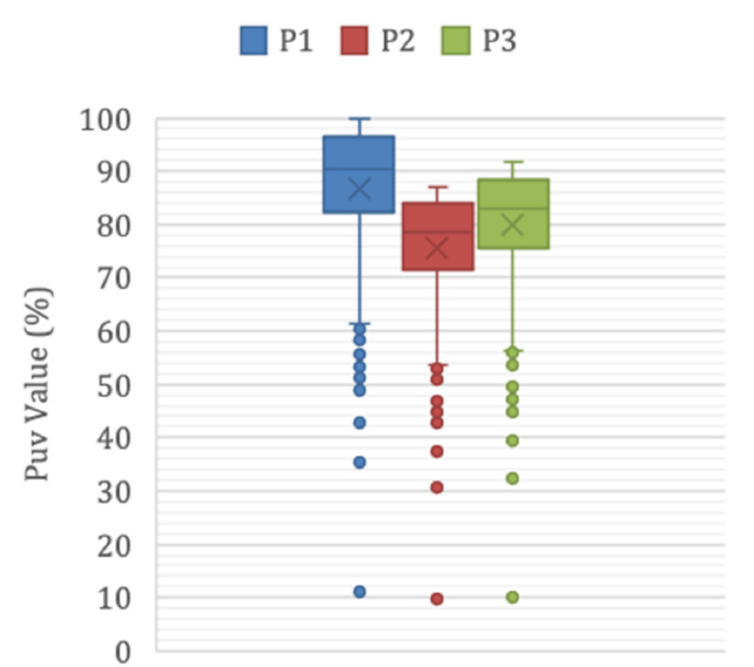
Figure 12. Distribution of average PUV values for the 1 K instances for which the algorithm can be